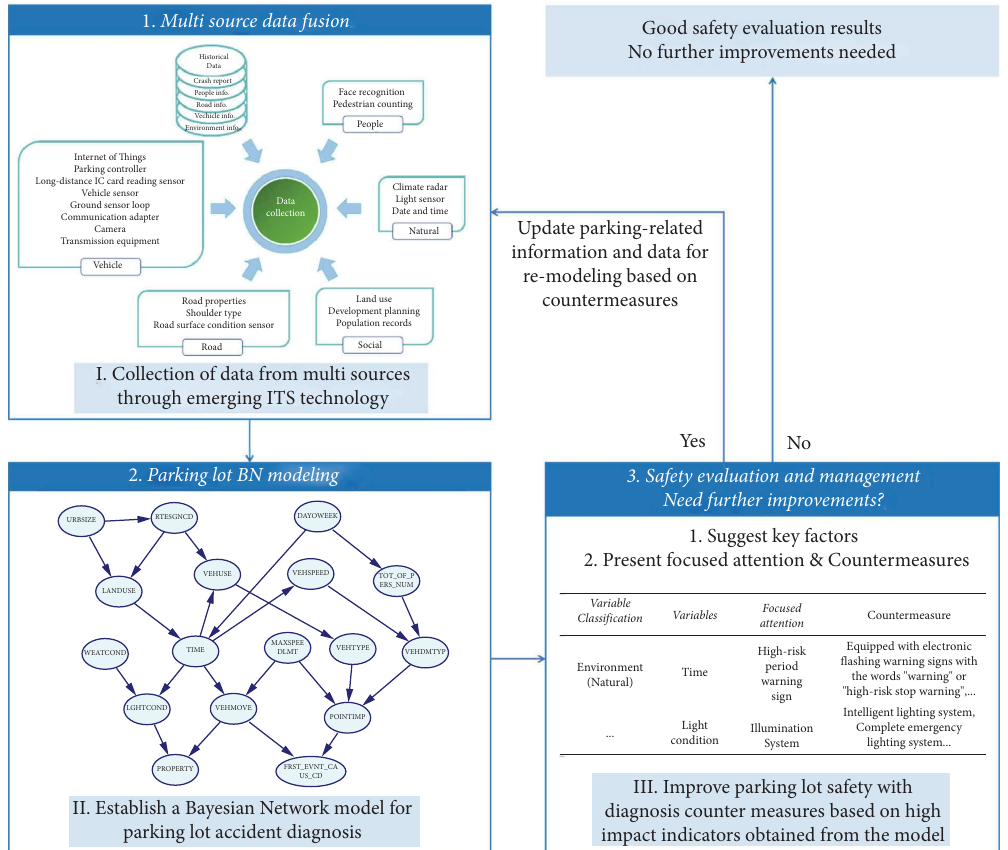
Figure 9: A Bayesian network-based parking lot safety evaluation density areas. Focused monitoring of attention indicators